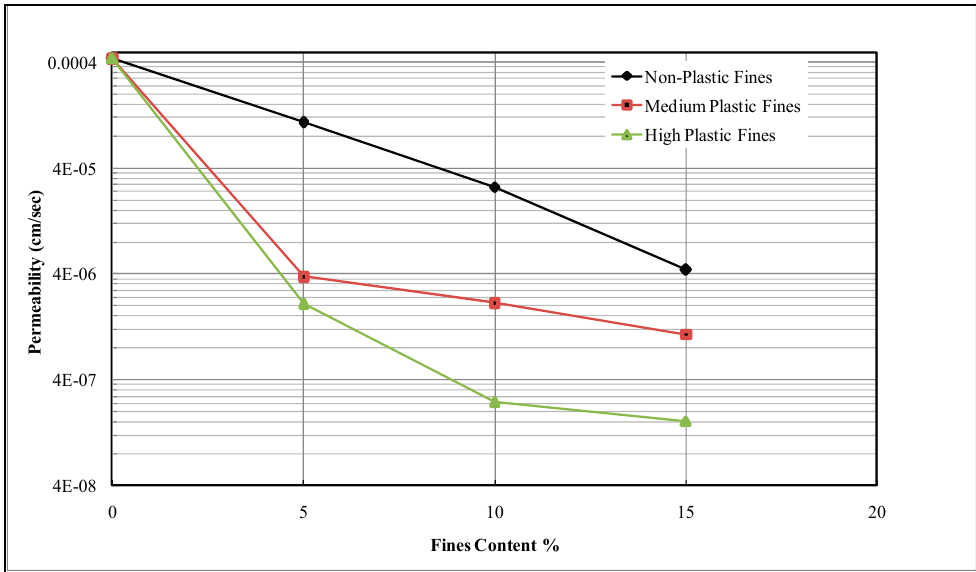
Figure 6. Effect of fines on permeability for the composite samples (gradation B).